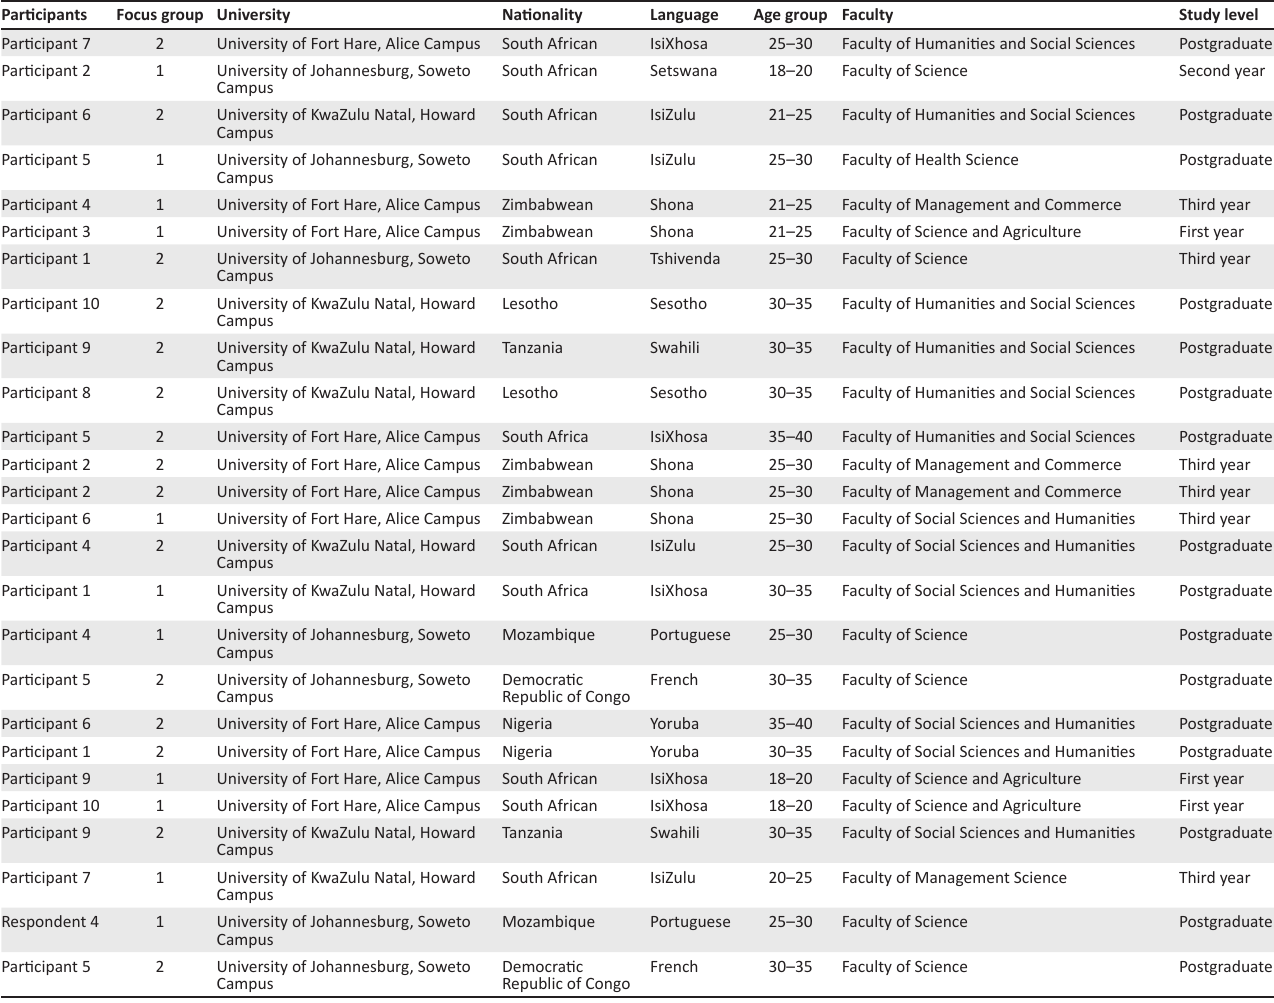
TABLE 1: Participants’